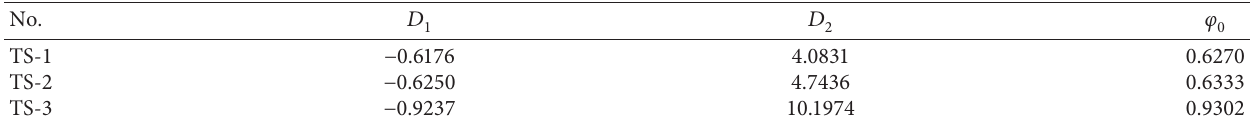
Figure 9: Experimental and fitting values of the relationship between early creep and age of concrete. Table 4: Test parameters and fitting parameters of